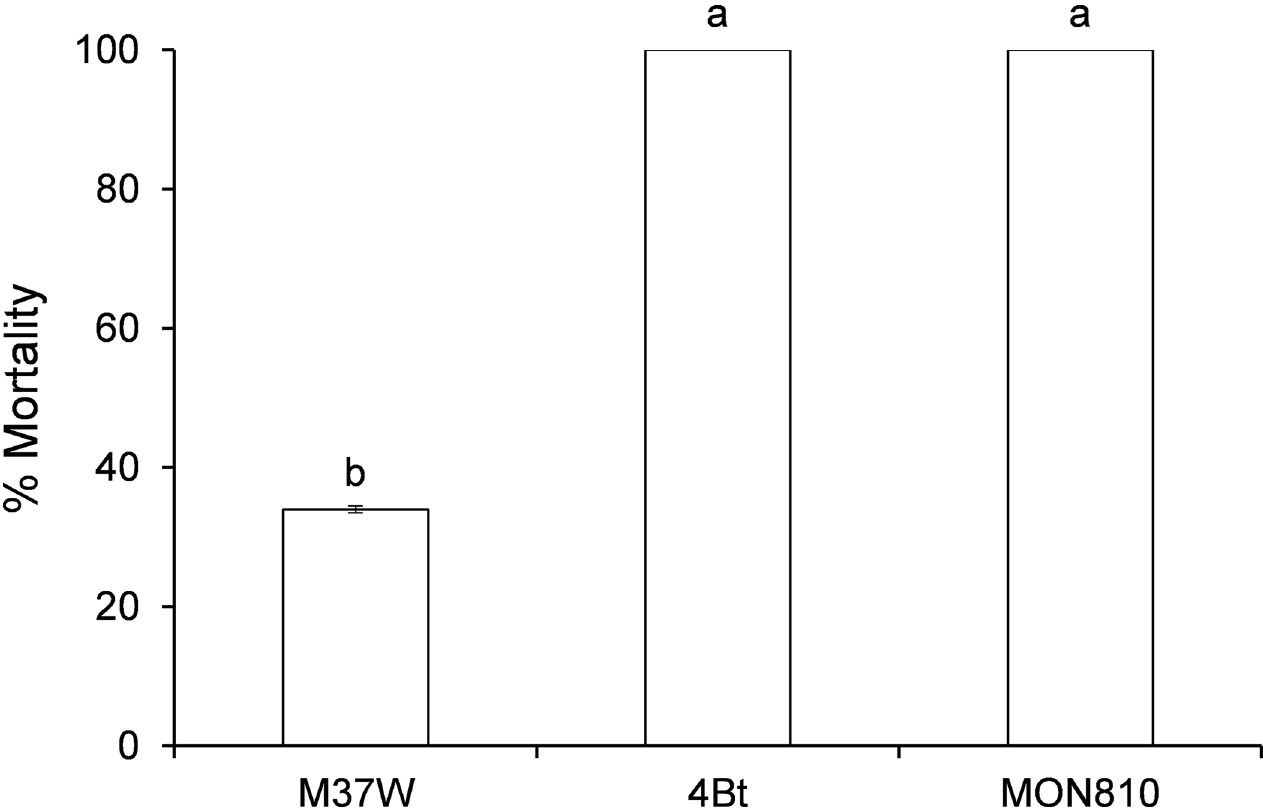
Fig 1. Mortality (mean ± S.E.) of Ostrinianubilalis neonate larvae when fed on leaves of different maize lines; larval mortality was recorded after five-day exposure (experiment 1). [F = 65.88; P < 0,001; df = 2,27]. 4Bt contained the Cry1Ac toxin, MON810 contained the Cry1Ab toxin, and M37W was the non-Bt near isogenic line of 4Bt. Different letters indicate statistically significant differences between the varieties (P < 0.001) when data were analysed by one-way (plant line) ANOVA.